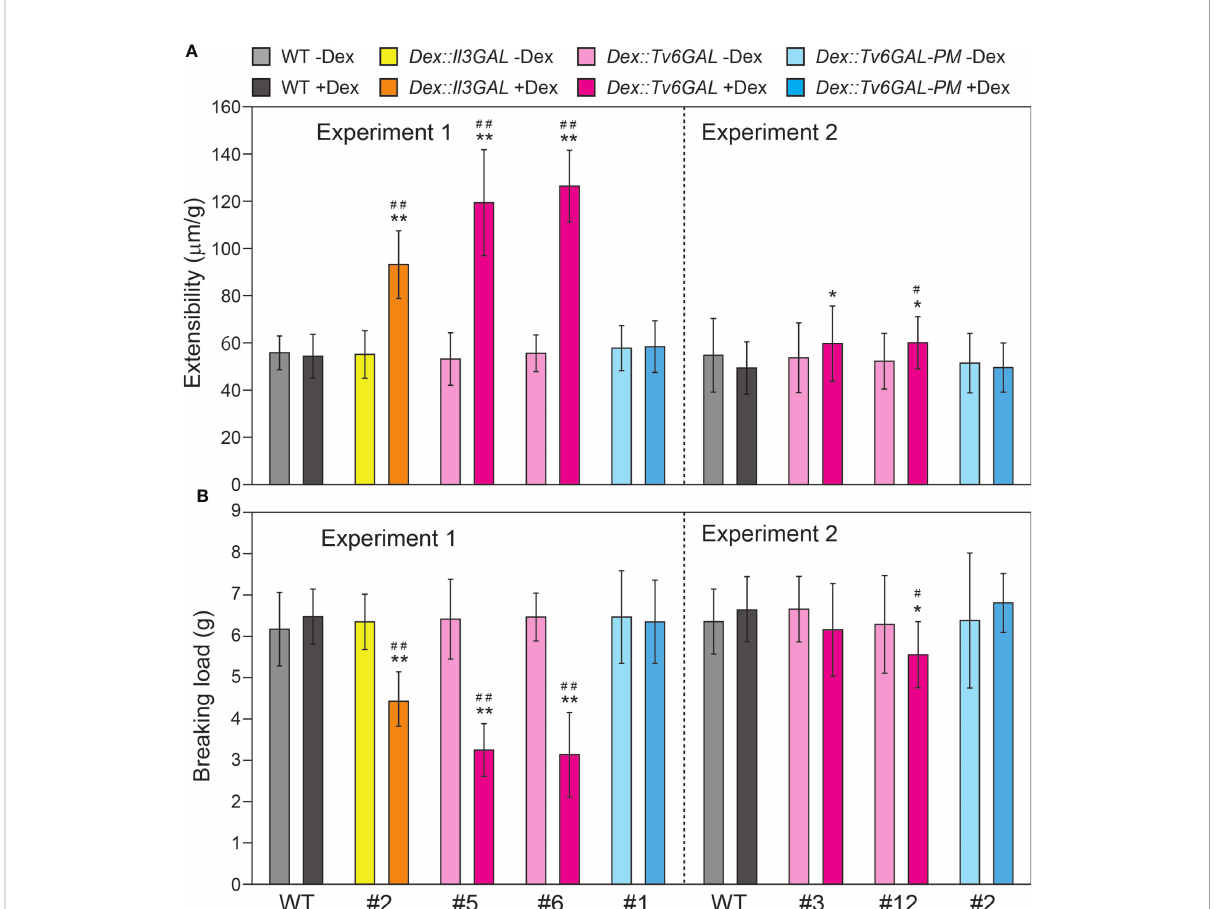
FIGURE 6 Mechanical properties of Dex::Tv6GAL plants. (A) Extensibility of hypocotyls. (B) Breaking load. The plants were grown on MS-agar plates with and without 10 µM Dex in the dark at 23°C for 5 days. The mechanical properties of the middle region of hypocotyls were measured by a tensile test. The data show mean values with ± SD, n = 20. Asterisks indicate signi fi cant differences from WT plants (Student ’ s t -test, *, P <0.05; **, P <0.01) and hash marks indicate signi fi cant differences between plants with and without Dex treatment (Student ’ s t -test, #, P <0.05; ##, P